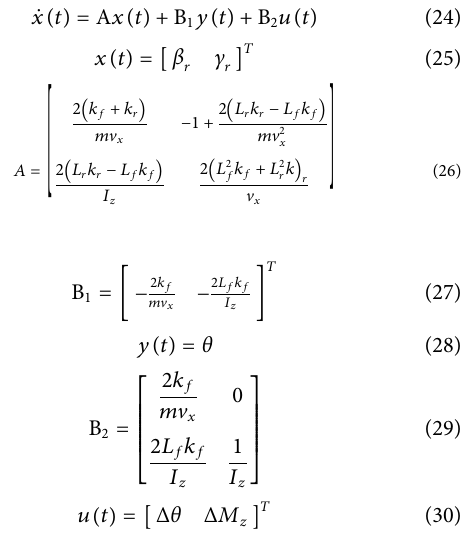
FIGURE 5 Comparison of vehicle trajectory.